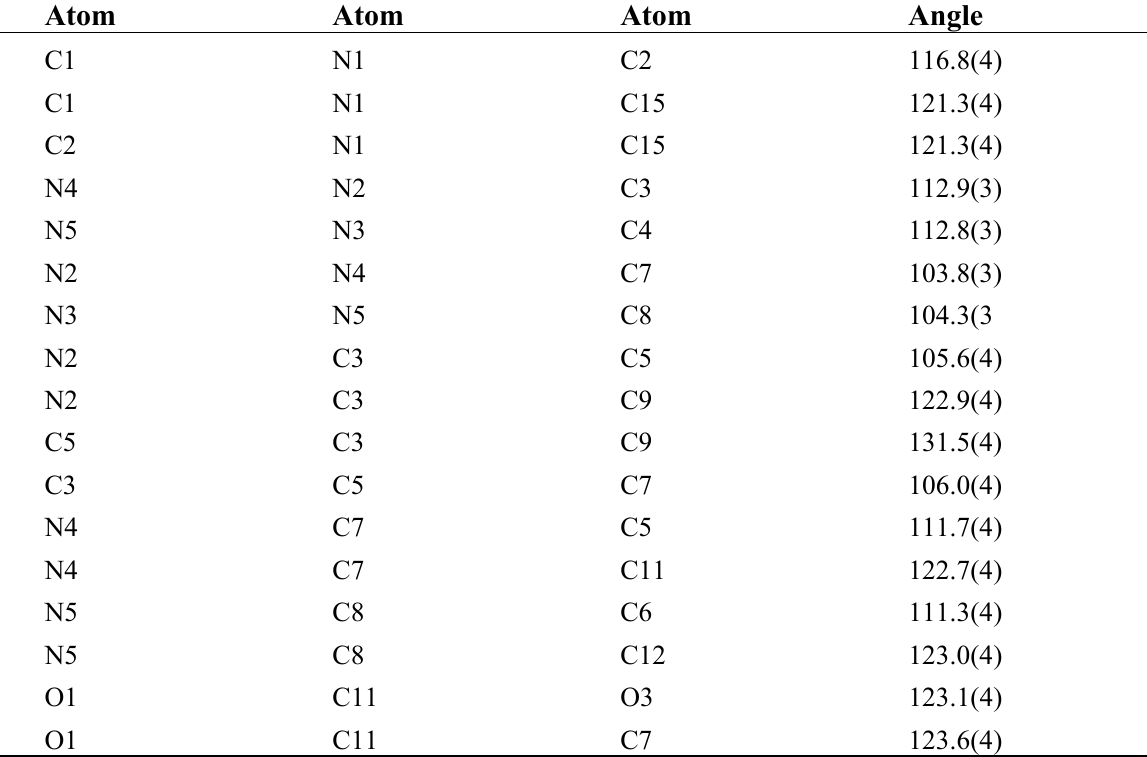
Table 4 : Selected bond angles (°) of tripodal ligand